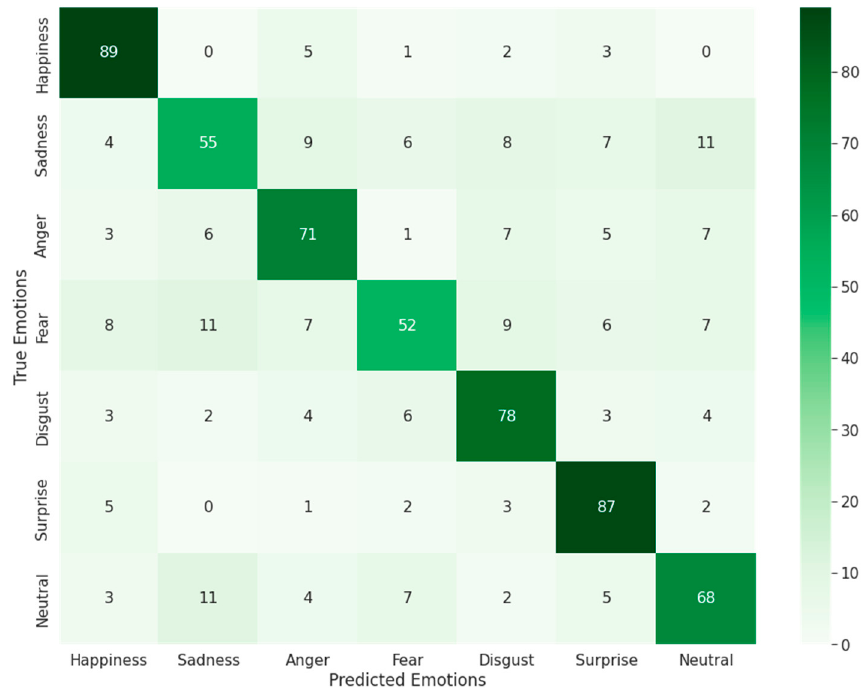
Figure 13. Performance of a confusion matrix for facial emotion recognition using the proposed model on the AffectNet